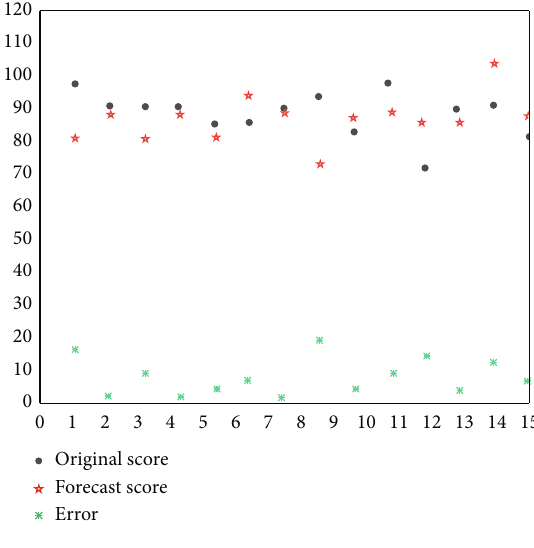
Figure 4: GA evaluation results.